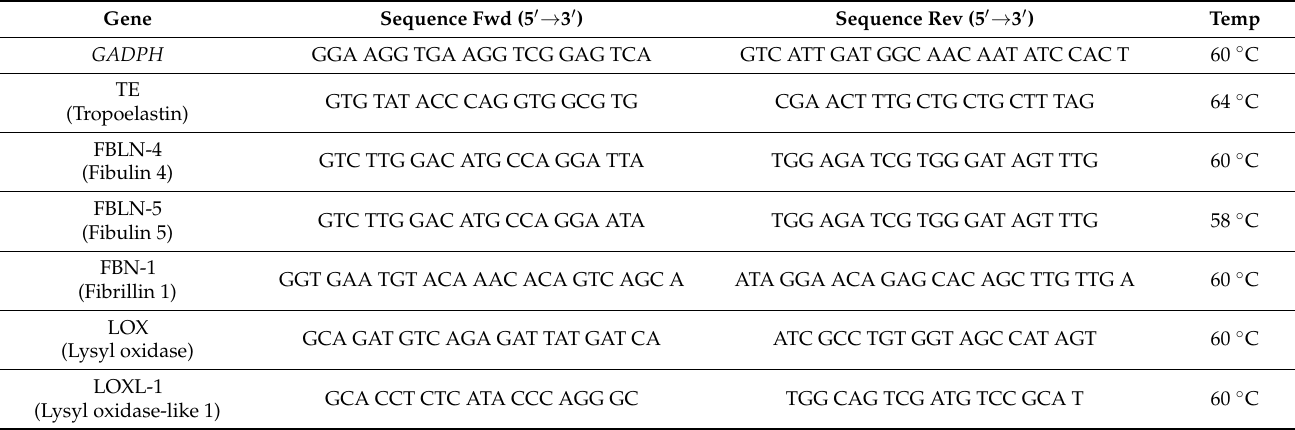
Table 3. Sequences of the primers and their binding temperatures in the RT-qPCR